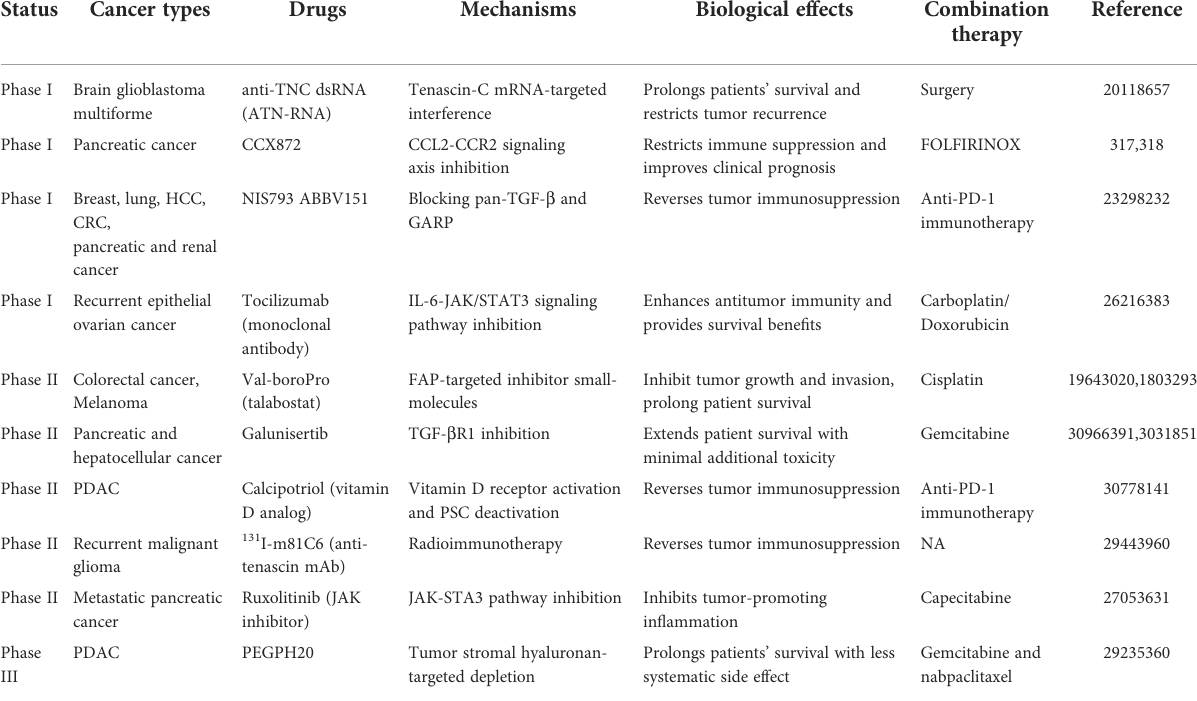
TABLE 3 Multiple clinical studies of CAF-targeted immunotherapy and related